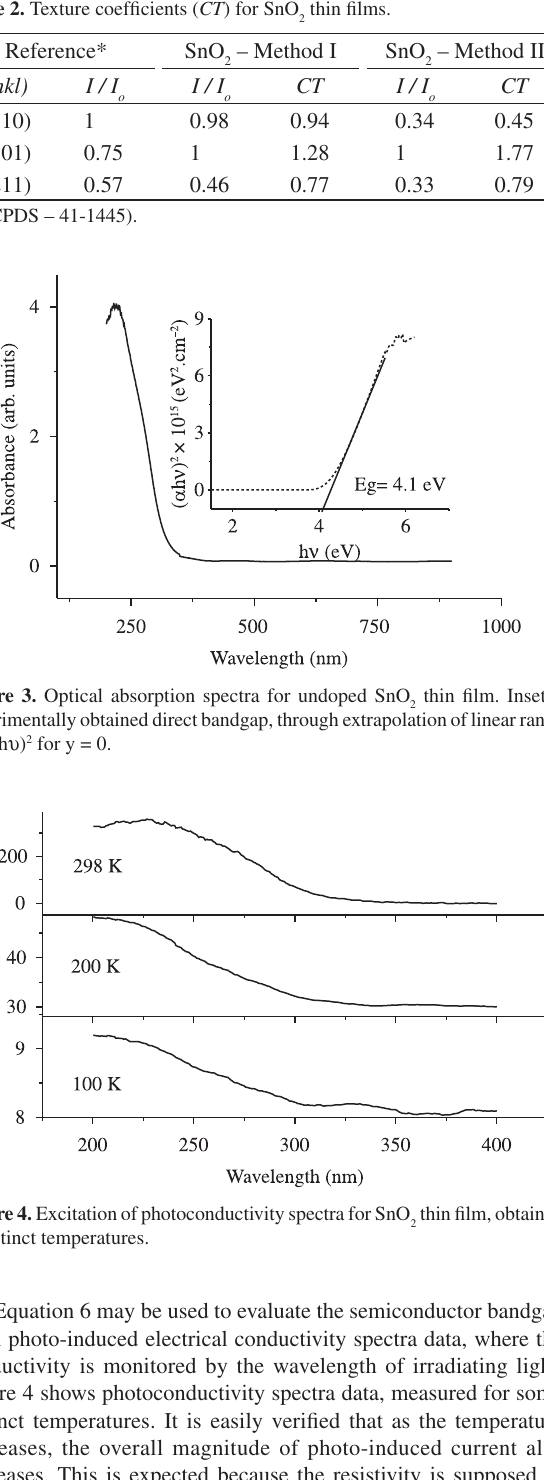
thin film, obtained 2